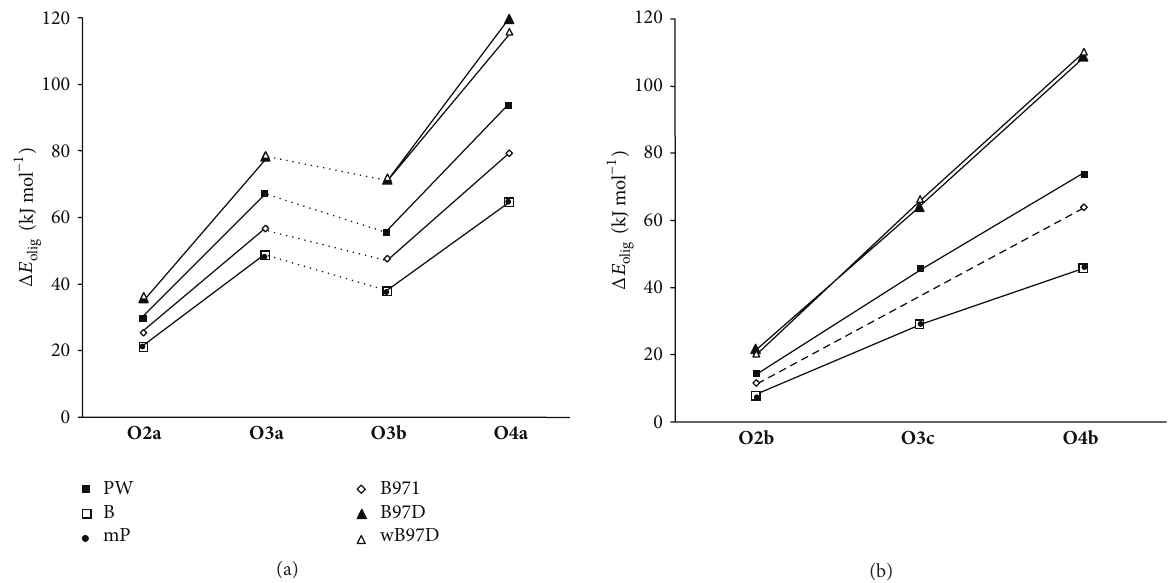
Figure 2: Variation of the CP-uncorrected Δ𝐸 as a function of oligomer size and DFT: (a) oligomers presenting just N–H ⋅ ⋅ ⋅ N interactions olig (group I) and (b) oligomers also C–H ⋅⋅⋅ N contacts (group